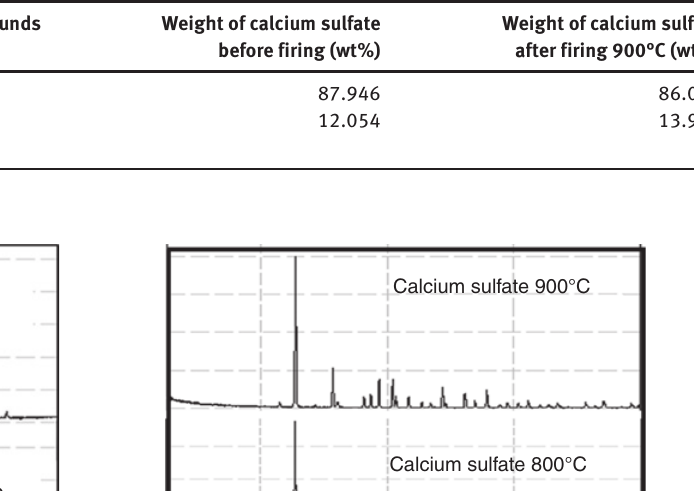
Table 3: Chemical compositions of calcium sulfate powders after firing measured by XRF.